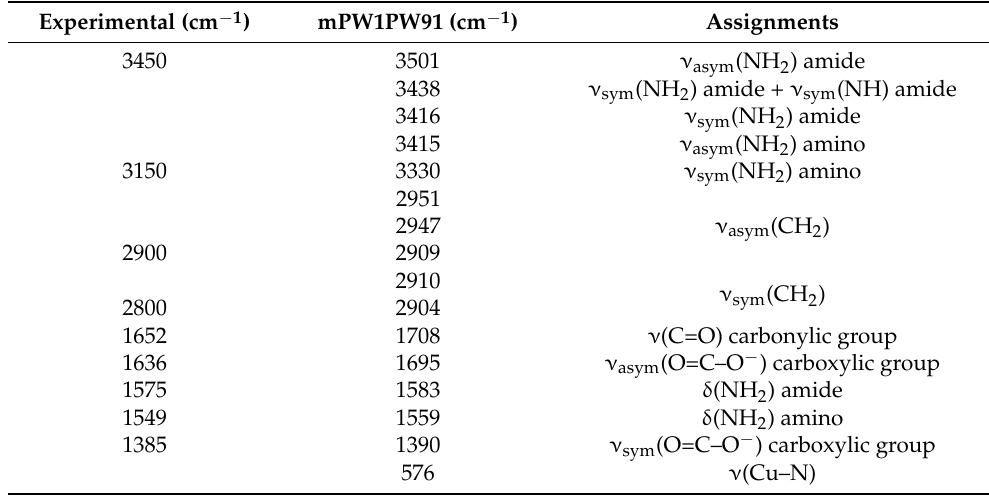
Table 5. FTIR experimental vibrational frequencies of [Cu(Citr) 2 ] n and FTIR calculated vibrational frequencies obtained at the level of theory mPW1PW91/6-31G(d)-LANL2DZ and ECP=LANL2DZ. Experimental (cm − 1 ) mPW1PW91 (cm − 1 )